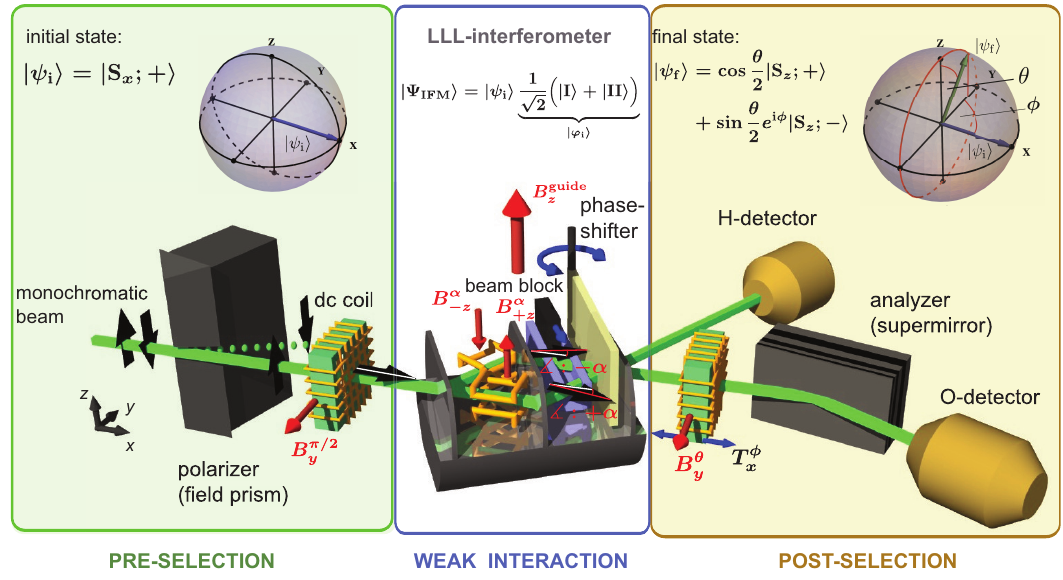
Figure 2. Schematic illustration of a triple Laue (LLL) neutron interferometer experiment for a weak measurement of the spin operator ˆ σ z . The setup consists of three stages: (i) pre-selection ( green ) using a magnetic field prism for polarisation and a π / 2 -spinrotator the initial state | ψ i (cid:105) = | S x ; + (cid:105) is prepared; (ii) weak interaction ( blue ) in the interferometer a weak spin rotation by ± α is applied in arm I and II, respectively; (iii) post-selection ( brown ) a combination of a spin-rotator and analysing supermirrow is used to post-select on the final state | ψ f ( θ , φ ) (cid:105) , before count rate